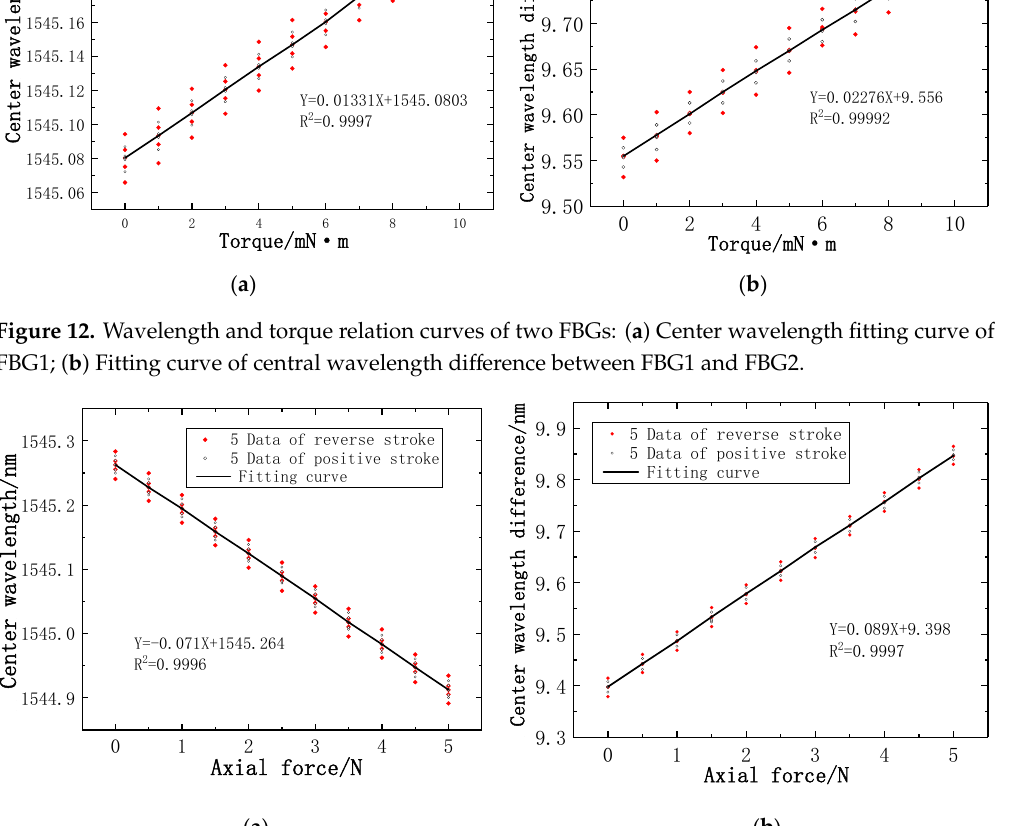
Figure 13. Wavelength and axial force relation curves of two FBGs: ( a ) Center wavelength fitting curve of FBG3; ( b ) Fitting curve of central wavelength difference between FBG3 and FBG2. In the experiment, the main sensing fibers are FBG1 and FBG3, FBG2 is a reference fiber. FBG2 is not affected by the pressure and torque force. The little change of temperature is the main factor affecting the Bragg wavelength of FBG2, so the trend of the values measured by FBG2 is not obvious. The Bragg wavelength of FBG2 fluctuates slightly up and down near the reference line, as presented in Figure 14.